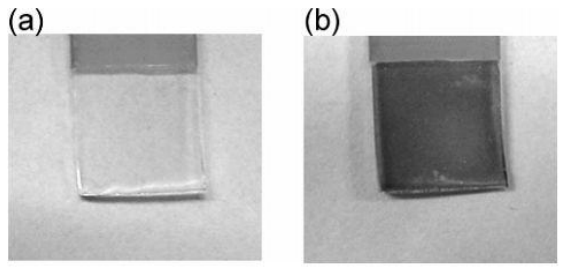
/Ni(OH) electrode (a) before irradiation, (b) after 2 2